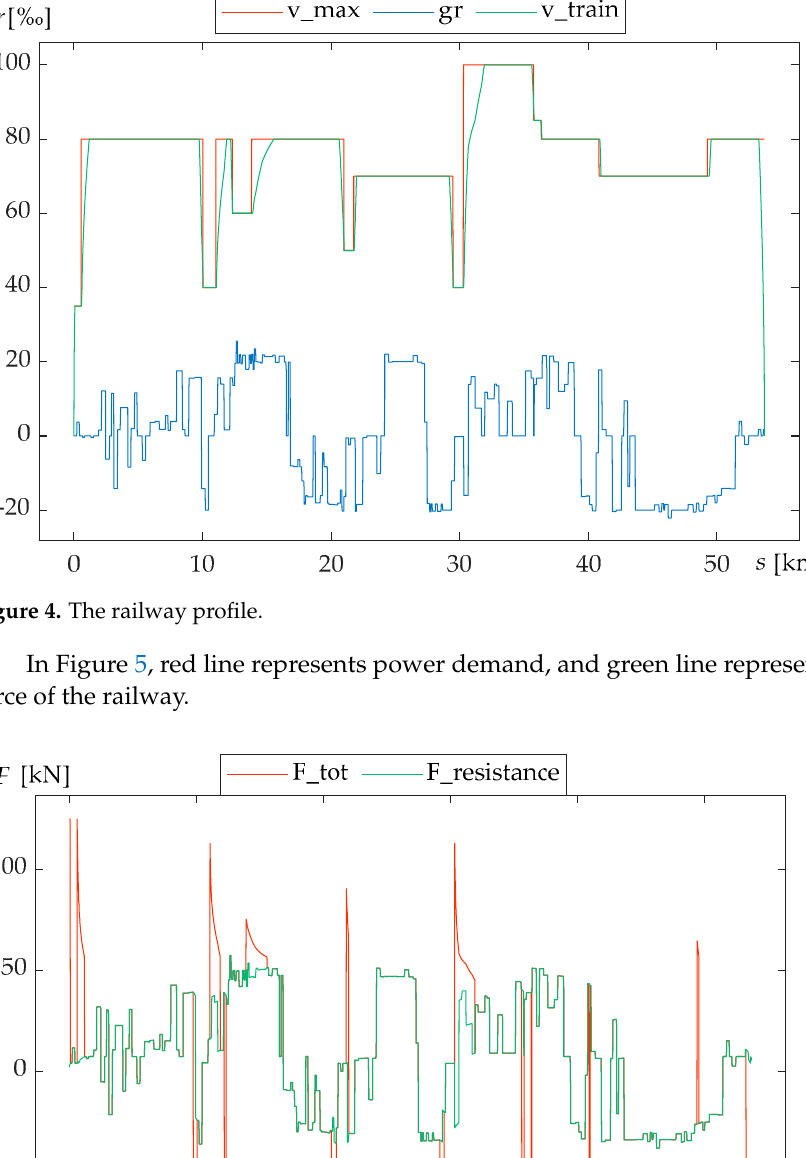
In Figure 4, the railway profile is depicted. The yellow line represents the gradient of the railway in ‰, the red line represents the speed limit, and the blue line represents train speed.